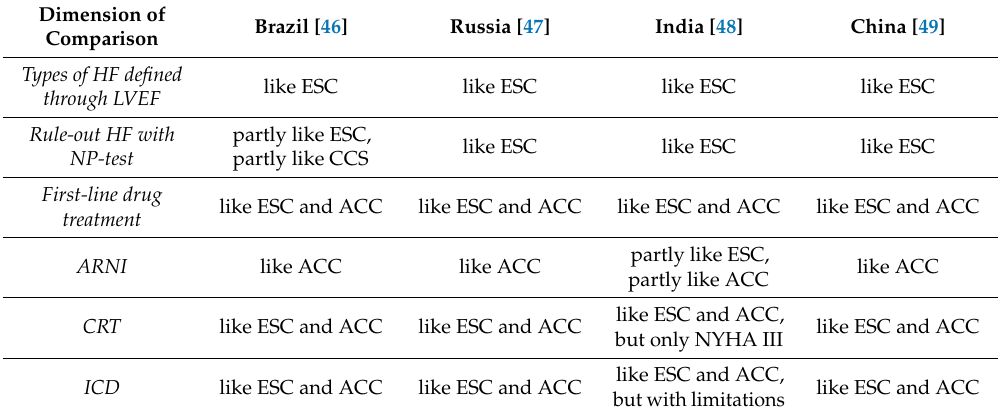
Table 2. Selected recommendations from recent CPGs on (chronic) heart failure (HF) 1